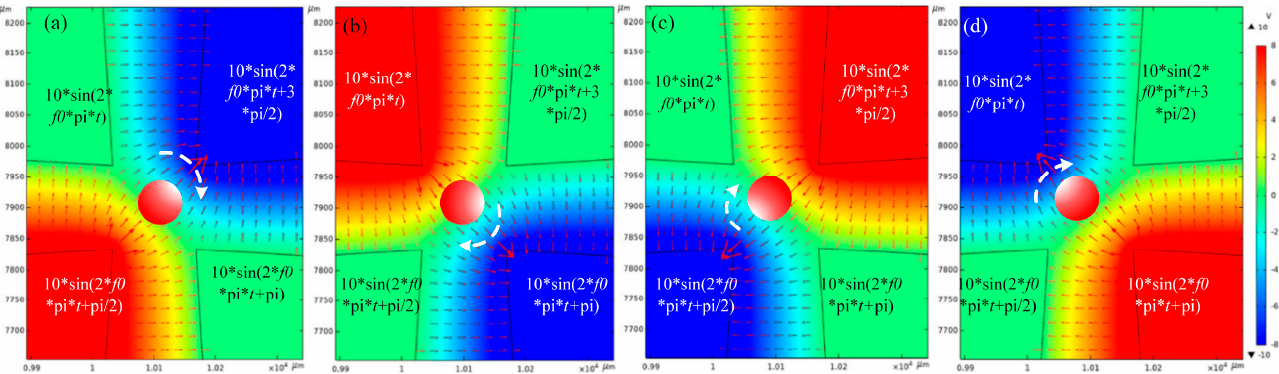
Figure 6. Electric field intensity simulation of particle rotation (V/m); ( a ) 0T moment, ( b ) 1/4T moment, ( c ) 1/2T moment, ( d ) 3/4T